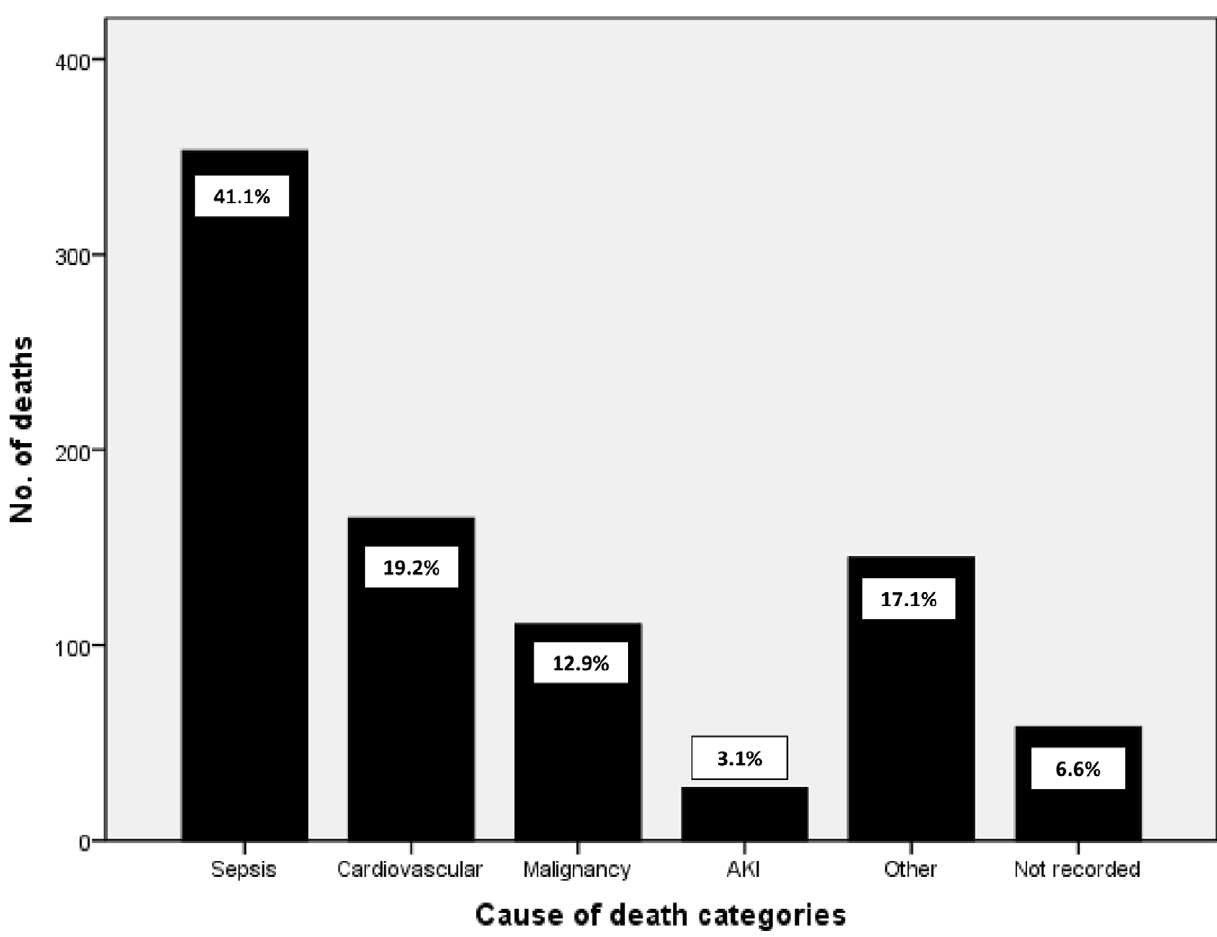
Figure 1. Frequency chart demonstrating major disease categories causing death in patients with AKI.